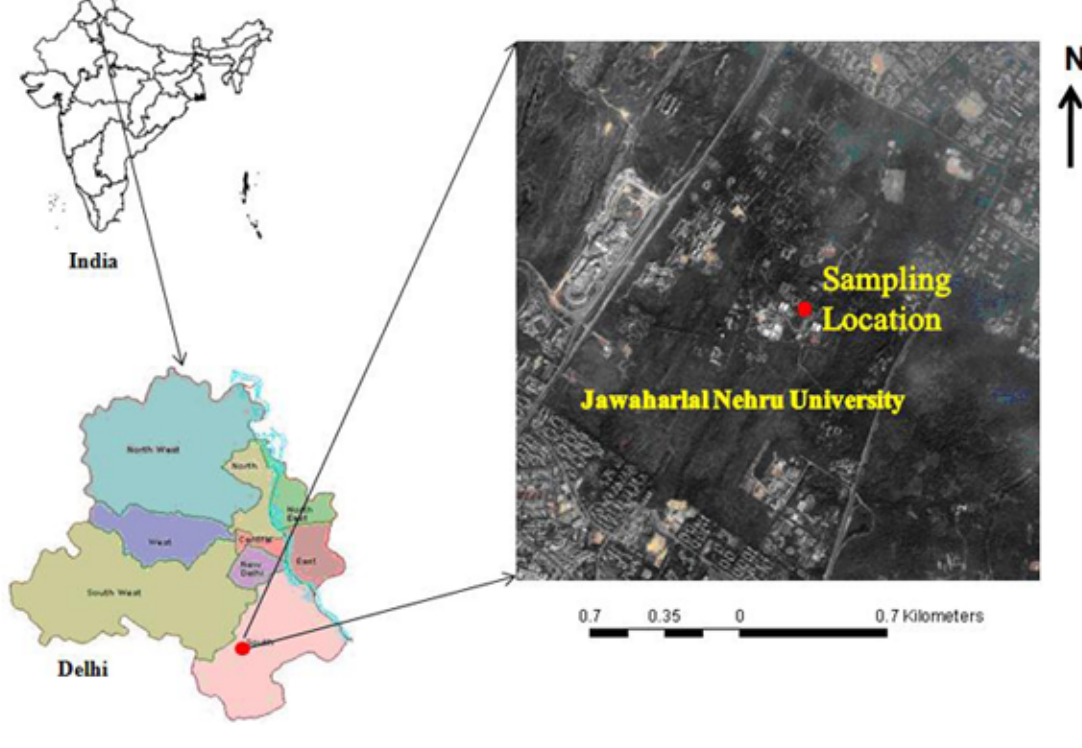
Fig. 1. Map showing sampling site and